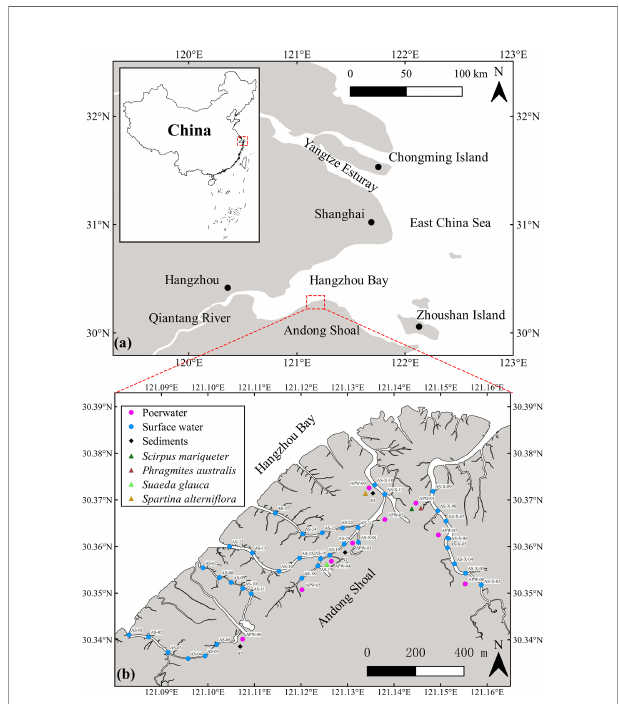
FIGURE 1 | (A) Location of the study area (Andong Shoal); (B) Sampling stations for creek surface water, sediments and